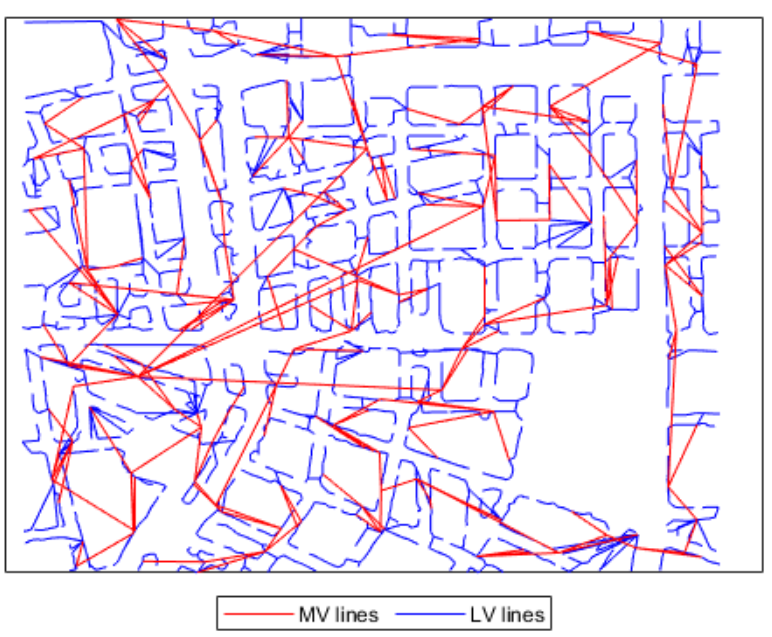
Figure 2. Urban reference network model